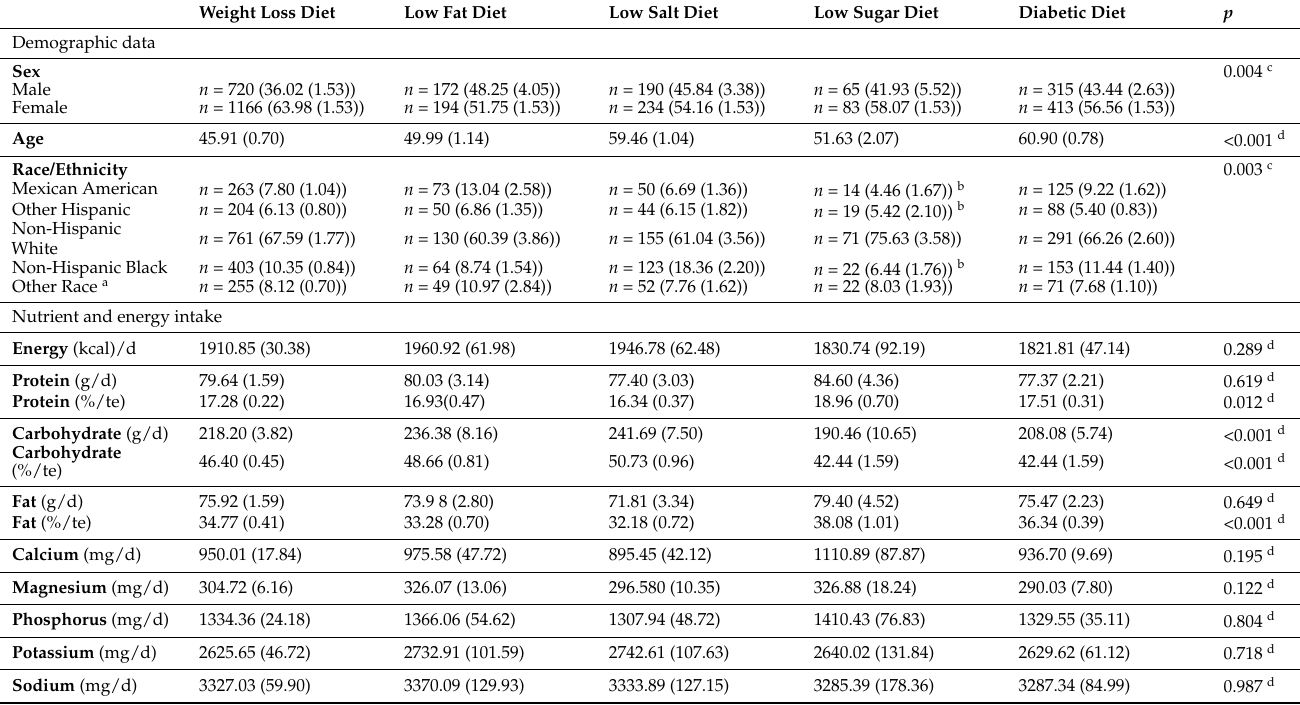
Table 1 legend: a = including Multi-Racial, b = unreliable estimated proportion as per NCHS guidelines, c = based on Stata’s design-adjusted Rao–Scott test, d = based on regression analyses followed by adjusted Wald tests. Abbreviations: te = total energy.